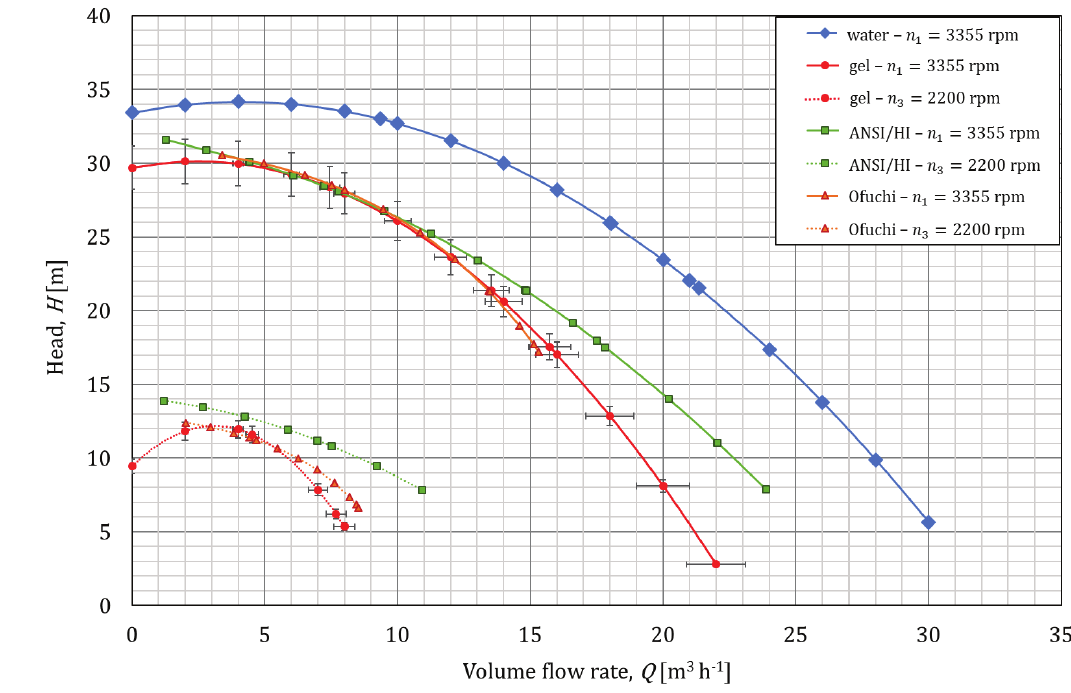
Fig. 7 – Measured (red curves ● with ± 5 % error) and predicted performance curves with gel at different rotational speeds with measured baseline curve with water as reference (thick blue with ◊). Green □: predicted with ANSI/HI method, orange Δ: predicted with Ofuchi